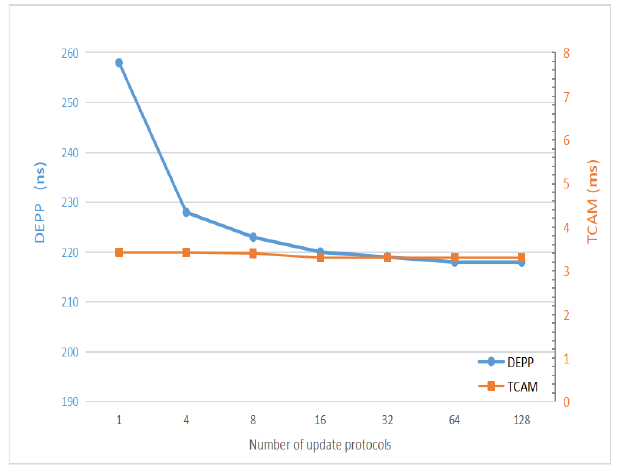
Figure 8. The average update